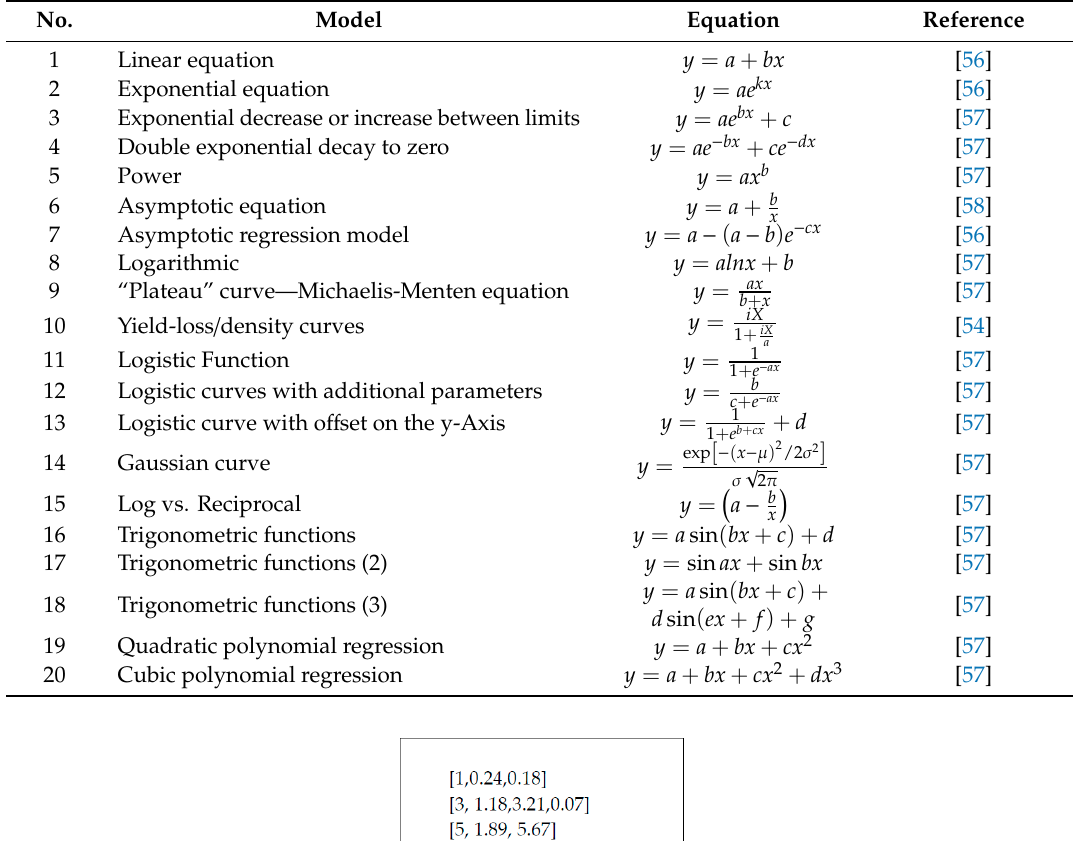
Table 2. Description of the analyzed models.